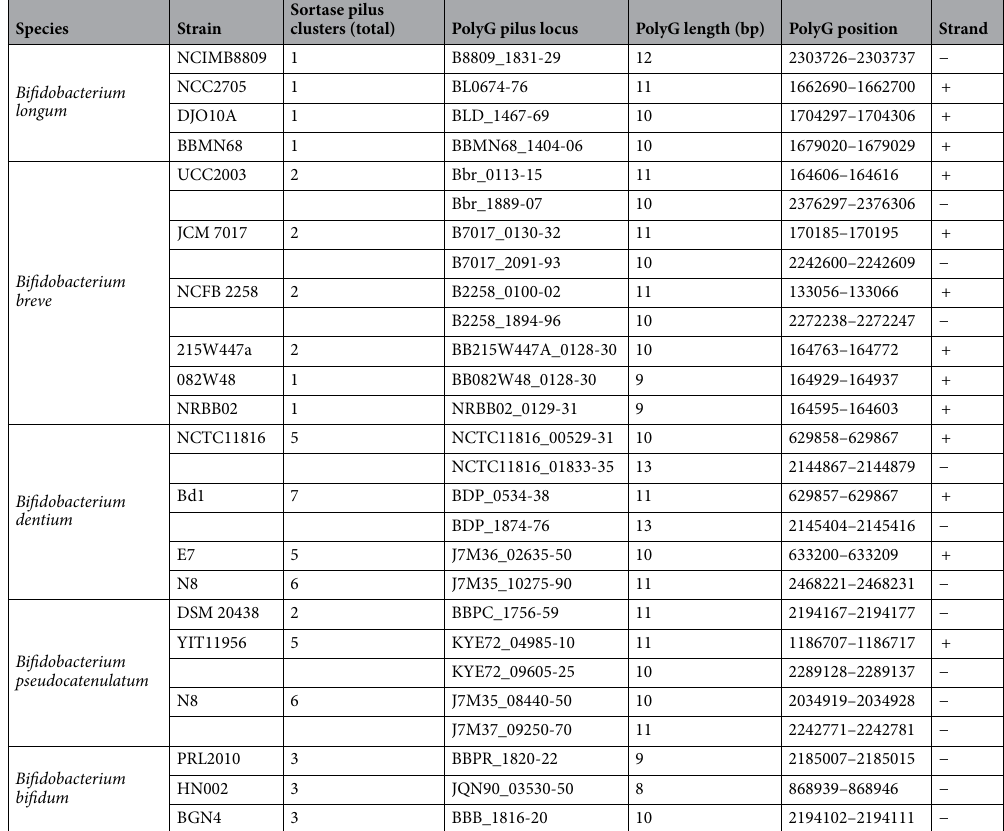
Table 1. G-tract mapping in sortase dependant pilus genes specified in other Bifidobacterium strains. Columns from left to right indicate the name of the bacterial species and strains, the number and name of sortase-dependent pilus cluster(s) containing a G-tract of specific nt length with the corresponding genomic coordinates and chromosomal DNA